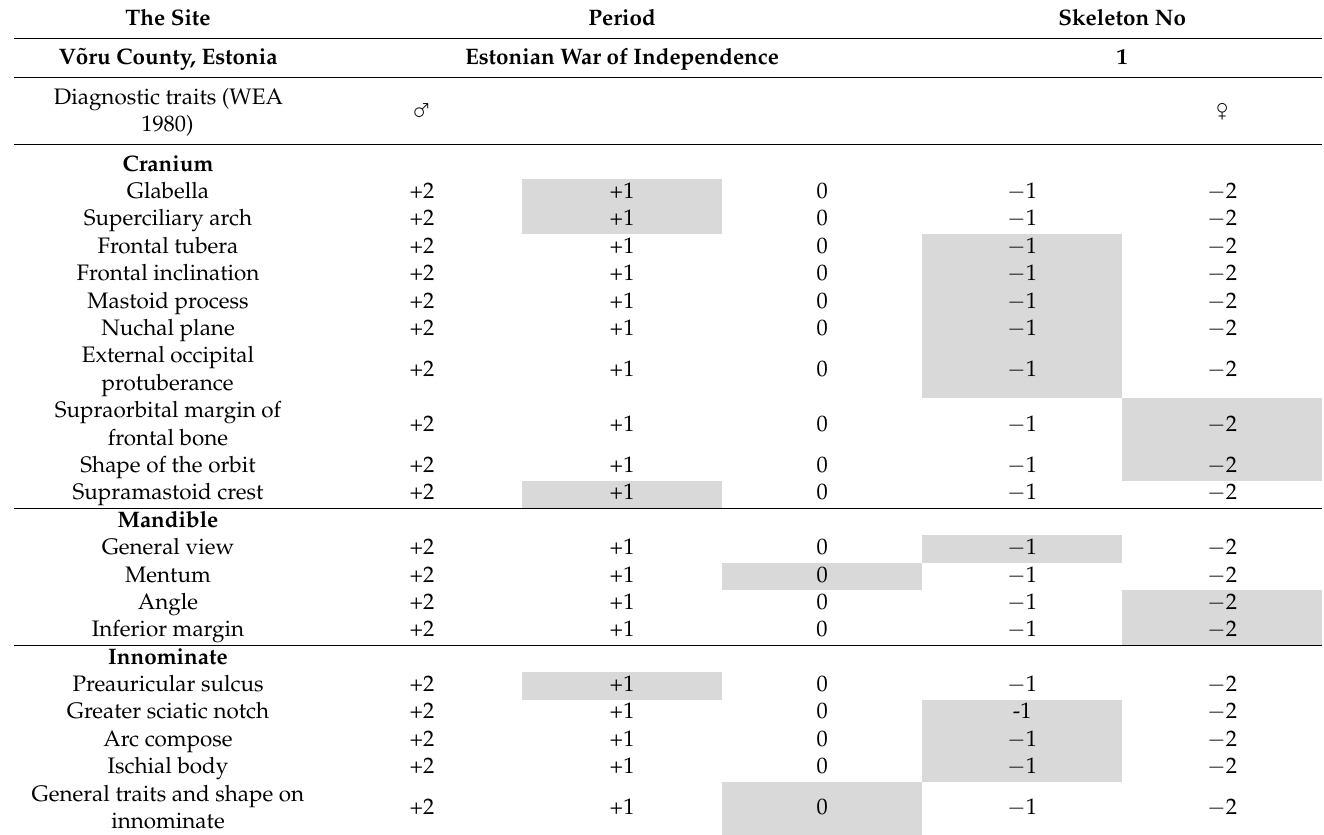
Table 1. Assessment of biological sex based on morphological traits [5].